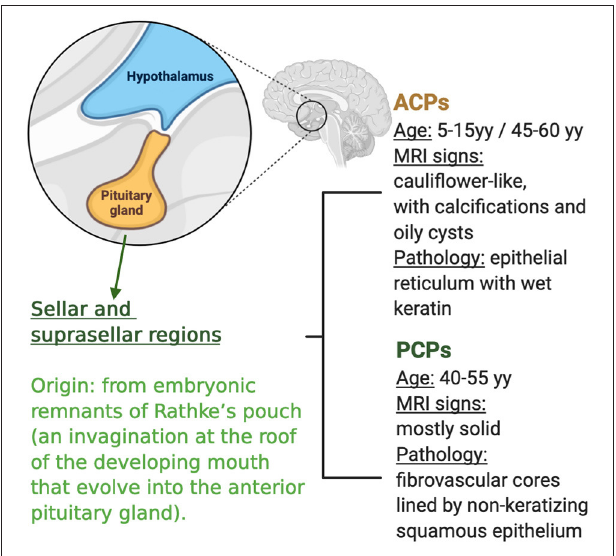
FIGURE 1 | Characteristics of craniopharyngioma and